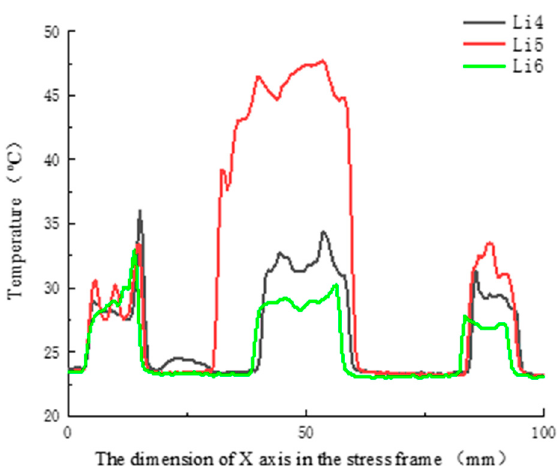
Figure 10. Temperature distribution graph of line 4, line 5, and line 6.